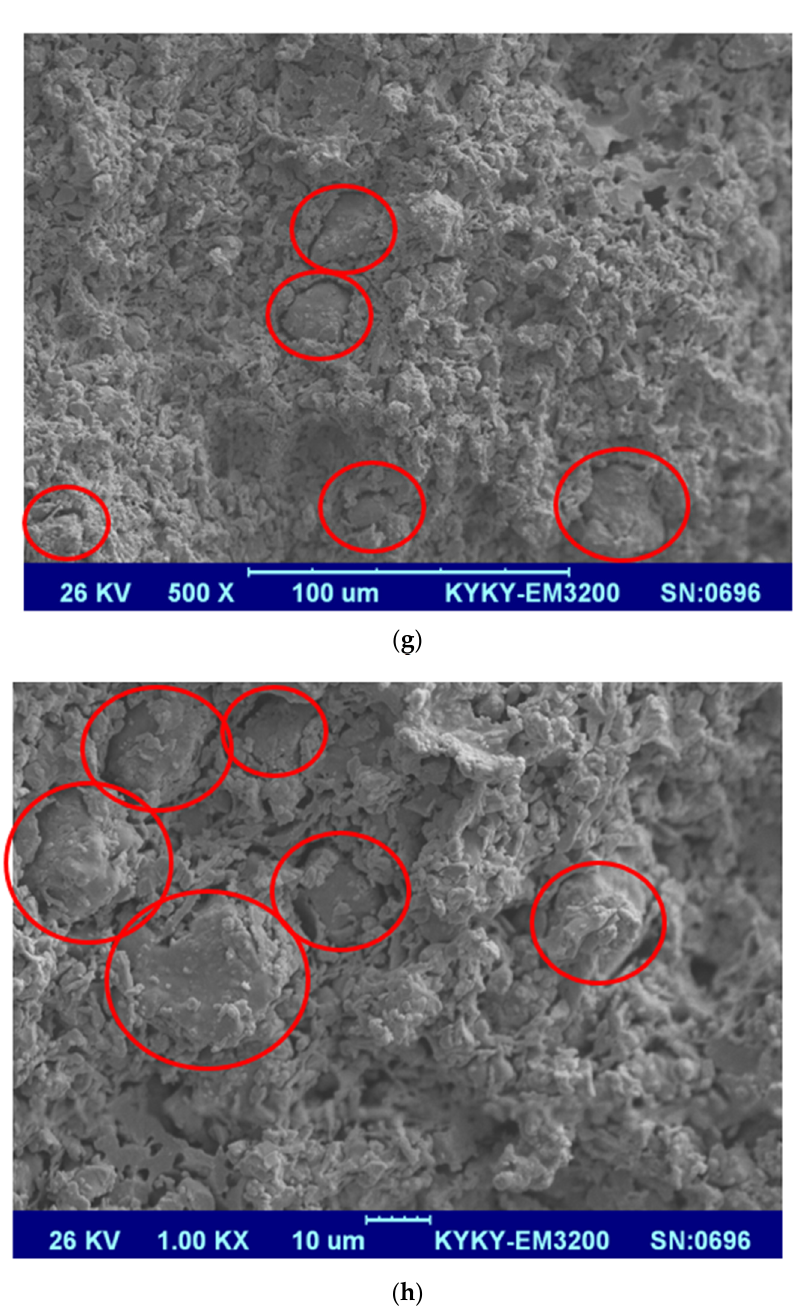
Figure 6. SEM image from the surface of ceramic membranes ( a ) mullite membrane with 500× zoom ( b ) mullite membrane with 5000× zoom ( c ) MA membrane with 1000× zoom ( d ) MA 50% membrane with 5000× zoom ( e ) MAZ 20% membrane with 5000× zoom ( f ) of MAZ 20% membrane with 10,000× zoom ( g ) MZ 40% membrane with 500× zoom ( h ) MZ 40% membrane with 1000× zoom.